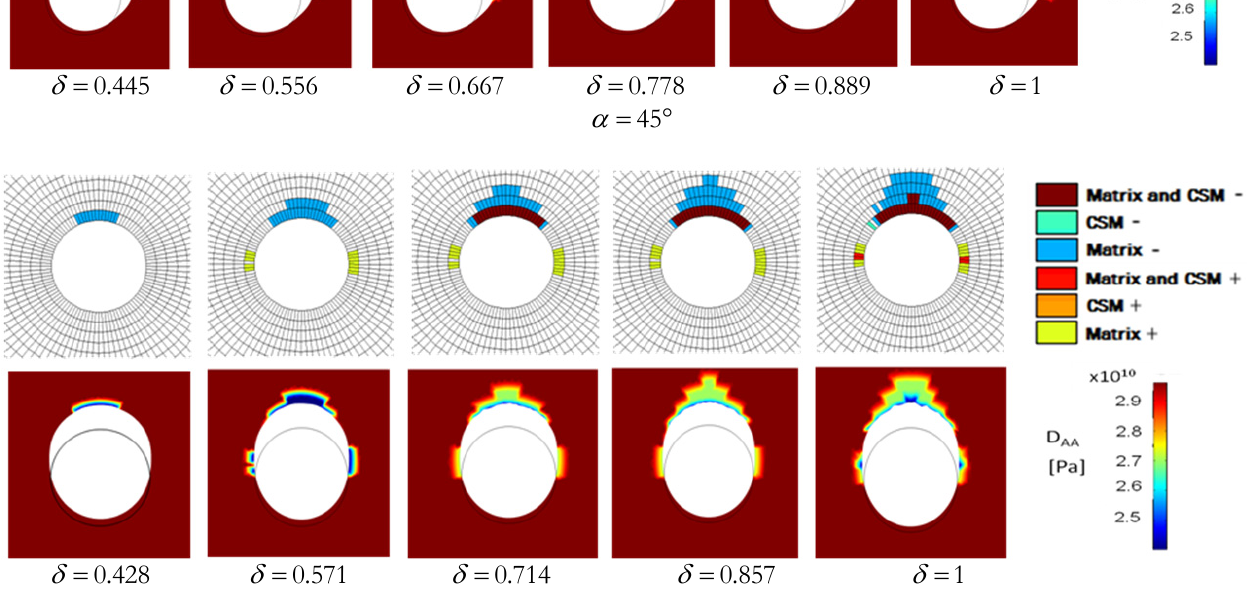
u is the pin displacement inducing the bearing failure. Moreover, D max